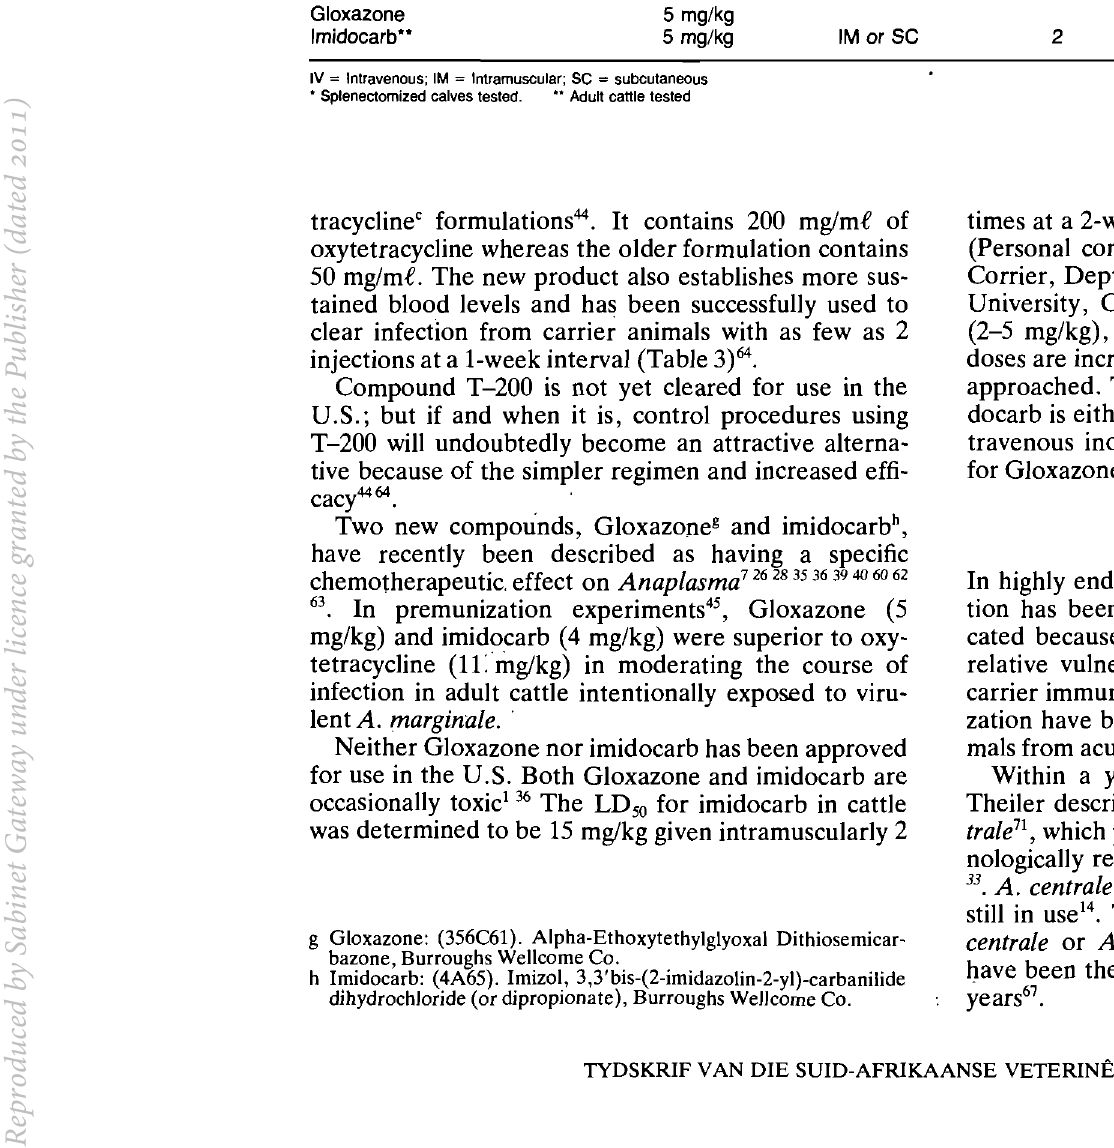
Table 4: TREATMENT REGIMENS USING OXYTETRACYCLINE PLUS GLOXAZONE, IMIDOCARB AND IMIDOCARB PLUS GLOXAZONE FOR THE ELIMINATION OF ANAPLASMA INFECTION39 Rate of